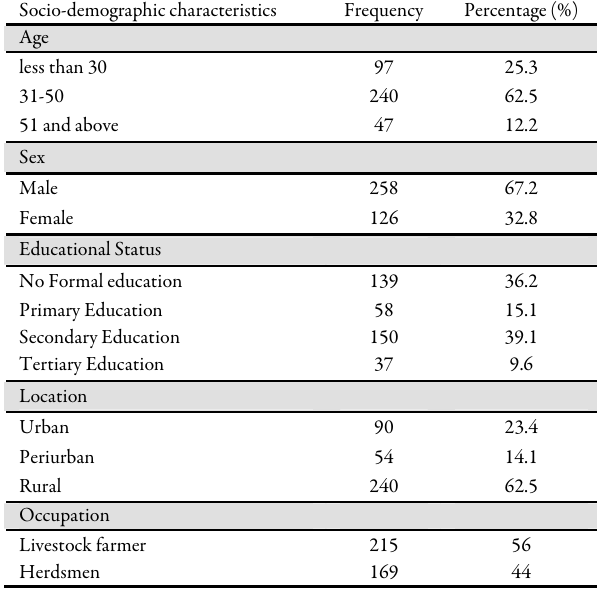
Table 1. Socio-demographic characteristics of the herdsmen and livestock farmers in the study area Socio-demographic characteristics